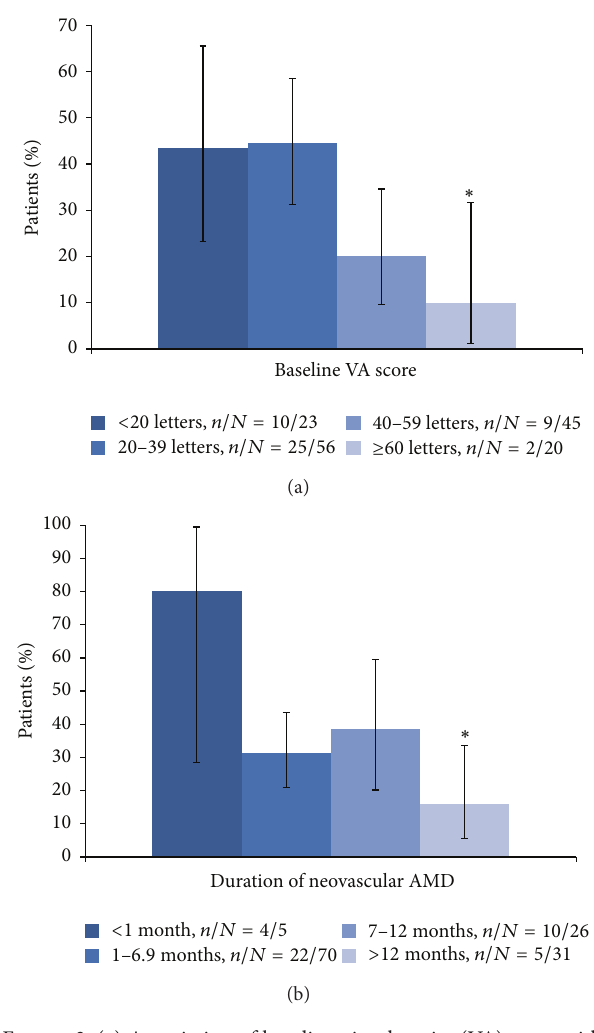
Figure 2: (a) Association of baseline visual acuity (VA) score with proportion of ≥ 15 letters gaining from baseline at 6 months. Baseline VA score was significantly associated with proportion of ≥ 15 letters gaining from baseline at 6 months ( 𝑃 = 0.005 ). ∗ 𝑃 = 0.015 (the first group was the reference). (b) Association of duration of neovascular age-related macular degeneration (AMD) with proportion of ≥ 15 letters gaining from baseline at 6 months. Duration of neovascular AMD was significantly associated with proportion of ≥ 15 letters gaining from baseline at 6 months ( 𝑃 = 0.021 ). ∗ 𝑃 = 0.009 (the first group was the